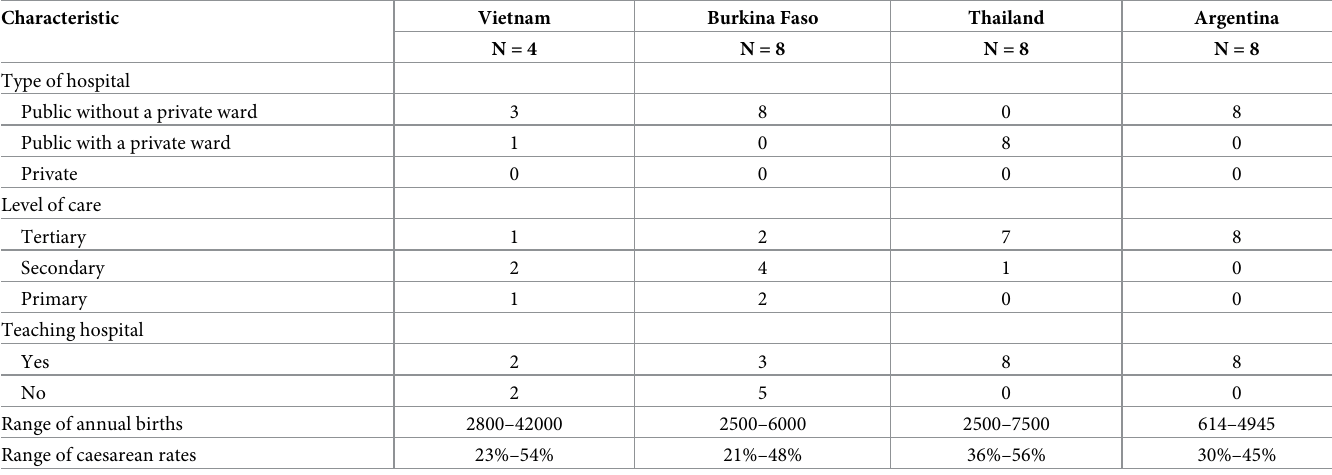
Table 1. Characteristics of the participating